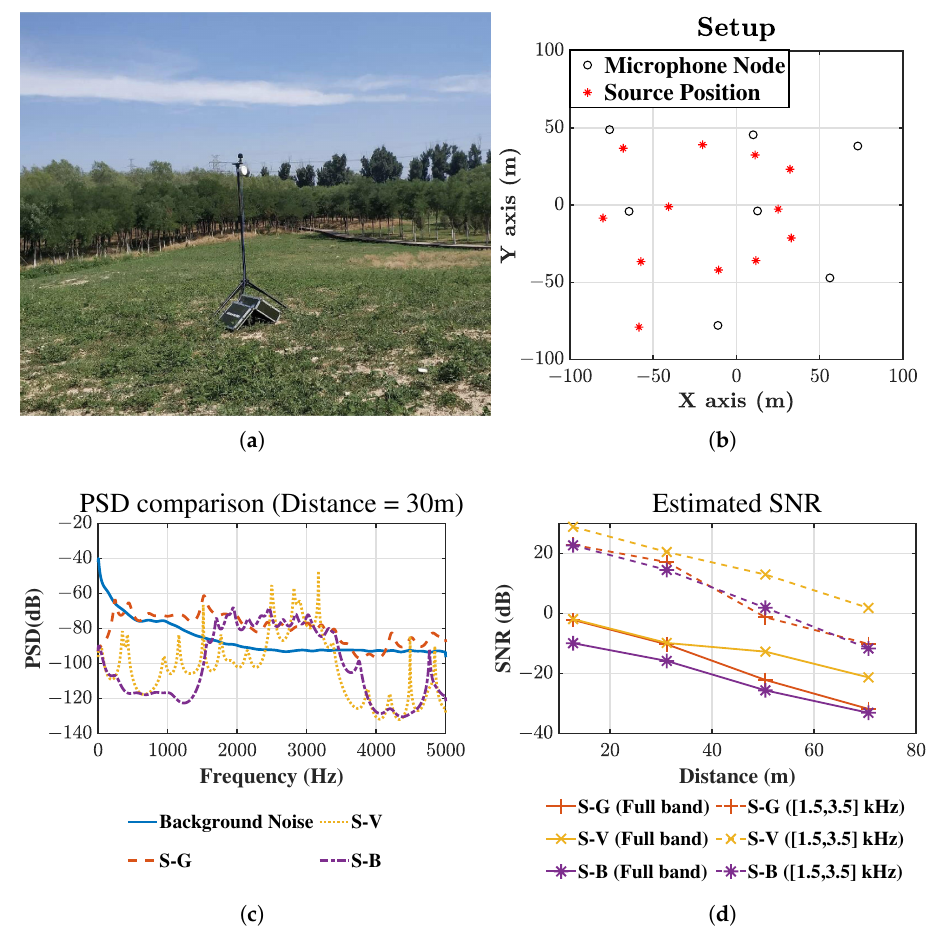
Figure 7. Setup of the field experiment ( a ) Device. ( b ) Distribution. ( c ) Estimated power spectrum density of sensor signal 30 m away from source. ( d ) Estimated signal to noise